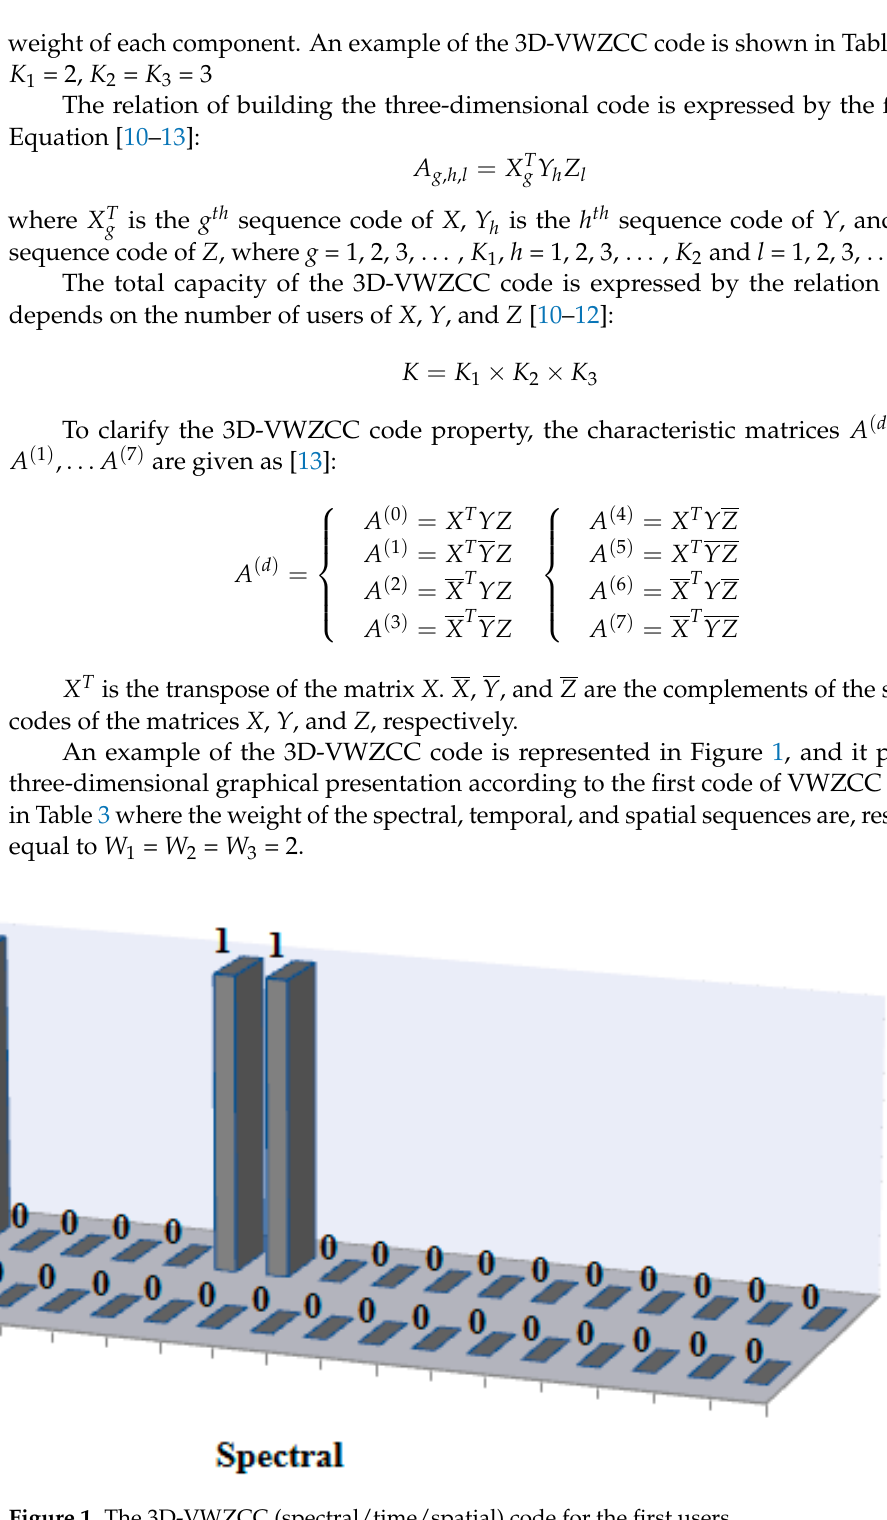
Figure 1. The 3D-VWZCC (spectral/time/spatial) code for the first users.